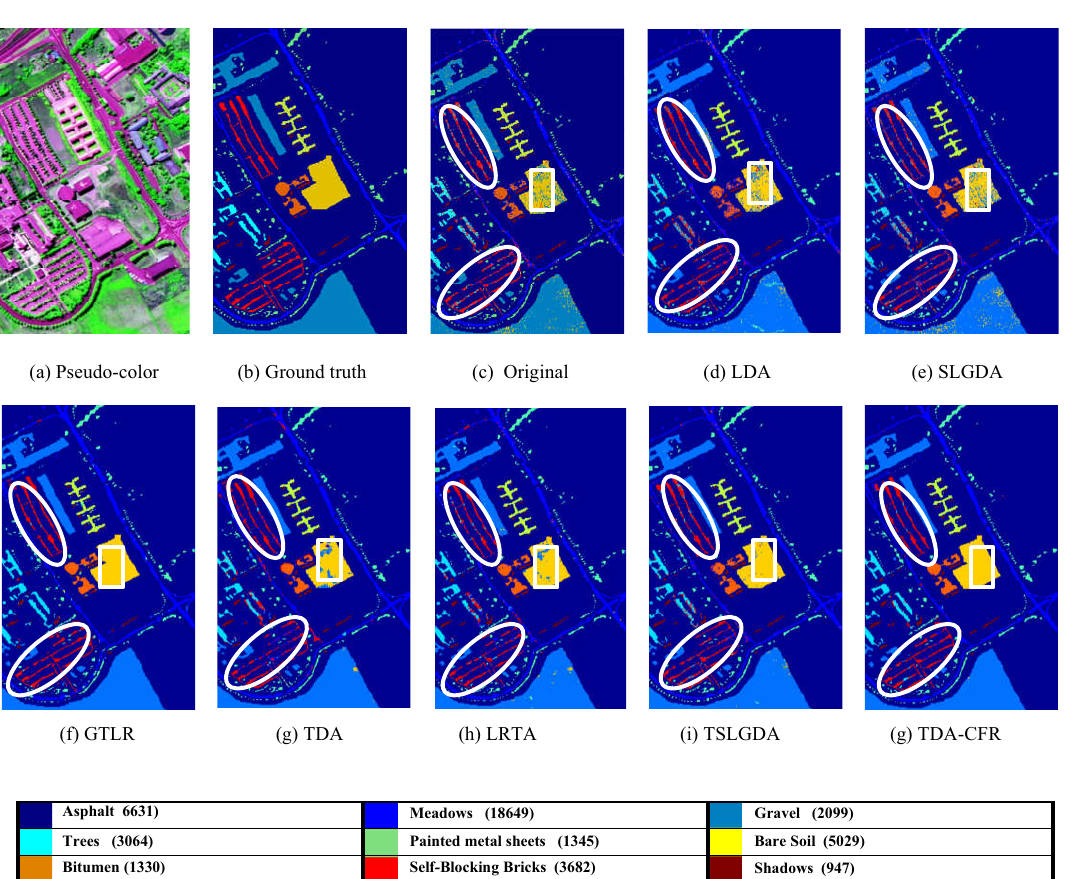
Figure 4. The classification maps on Pavia